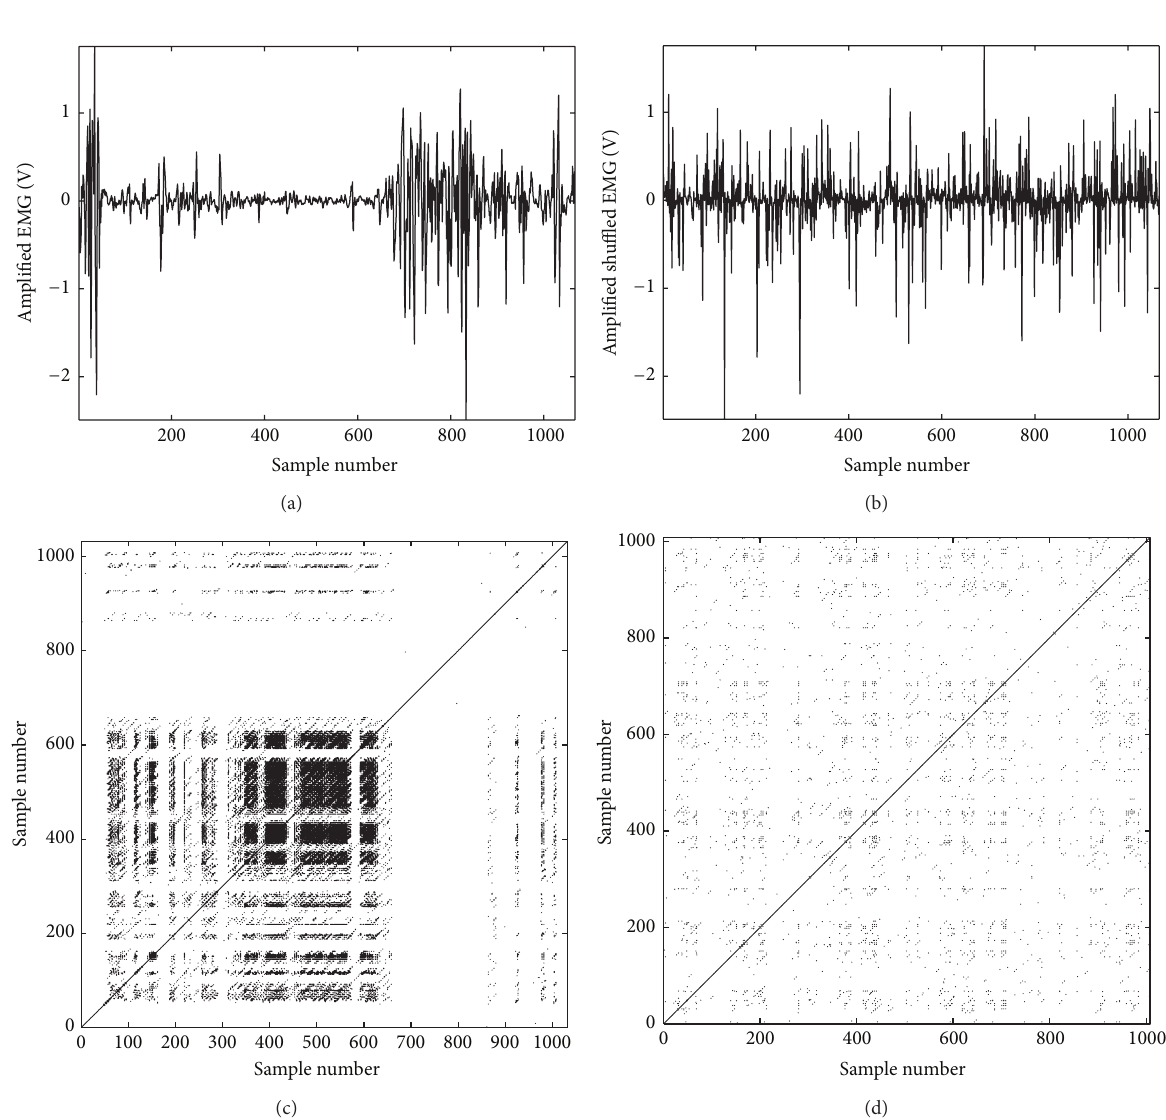
Figure 4: Neuromuscular activity of tibialis anterior (TA) muscle during a gait cycle depicted by EMG activity. (a) TA is active during the initial phase of gait cycle (heel contact), with a reduction of activity towards the plantar flexion position. From the midstance toward the terminal stance, the dorsiflexion of ankle is managed by higher activity of TA. The recurrence plots (RP) generated based on the original data are shown in graph (b) indicating the existence of a specific pattern in TA activity during the gait cycle. This pattern is depicted by several recurrent points located along particular diagonal lines which are parallel to the main diagonal line. The outcome of the RQA also verified the existence of the aforementioned pattern (%REC = 1.93, %DET = 34.80, radius = 1.92 (maximum scale), and ApEn = 0.63). (c) contains the randomized shuffled data of the signal shown in (a); (d) is the RP of the randomized signal which shows no significant determinism in the shuffled data. The time delayed dimensional data in RP are randomly scattered around the main diagonal line and the recurrent points are positioned along very short length. In addition, the outcome of RQA has shown significant reduction in determinism in the randomized data (%REC = 0.44, %DET ≅ 0, radius = 1.92 (maximum scale), and ApEn = 1.93). The significant drop in the determinism of the signal detected by decreasing %DET and increasing ApEn verified the nonlinear dynamics of the collected EMG